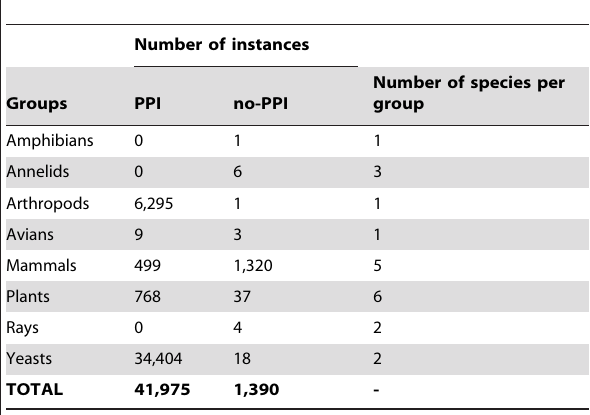
Table 4. Descriptions of instances inserted in the training set.